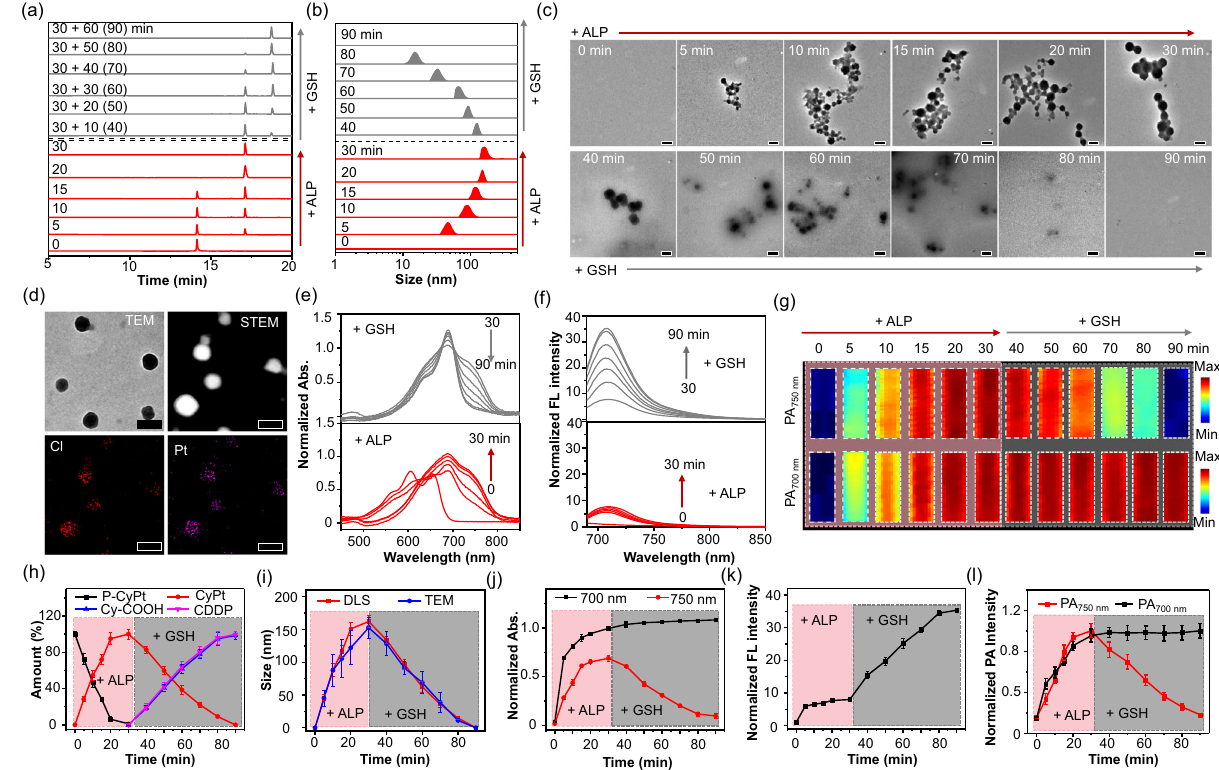
Fig. 2 | Characterization ofALP-triggered in situ self-assembly and GSH-driven disassembly of P-CyPt in vitro. a High-performance liquid chromatography (HPLC) trace, b dynamic light scattering (DLS) analysis, c transmission electron microscopic (TEM) analysis of P-CyPt (10 μ M) incubated with alkaline phosphatase (ALP,100U/L, 37°C) in Tris buffer for 0 – 30min, followed by addition with glu- tathione (GSH,10mM) and incubation for another 0 – 60min. Scale bars: 200nm. d TEM image, scanning transmission electron microscopic (STEM) image, and elemental mapping of Pt IV NPs formed by incubating P-CyPt (10 μ M) with ALP (100U/L, 37°C) for 30min. Color red and magenta indicate elements of chlorine (Cl) and platinum (Pt), respectively. Scale bars: 200nm. e Ultraviolet – visible (UV- vis)absorption(Abs.), f fl uorescence (FL)spectraand g photoacoustic(PA)images (at 700 and 750nm) of P-CyPt (10 μ M) incubated with ALP (100U/L, 37°C) in Tris